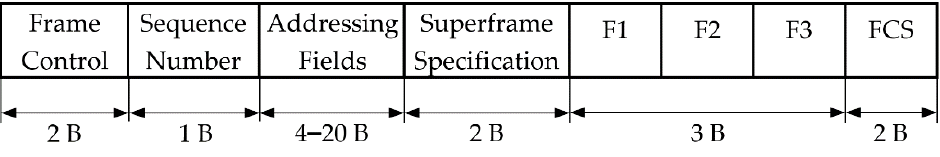
Figure 5. Beacon frame format.